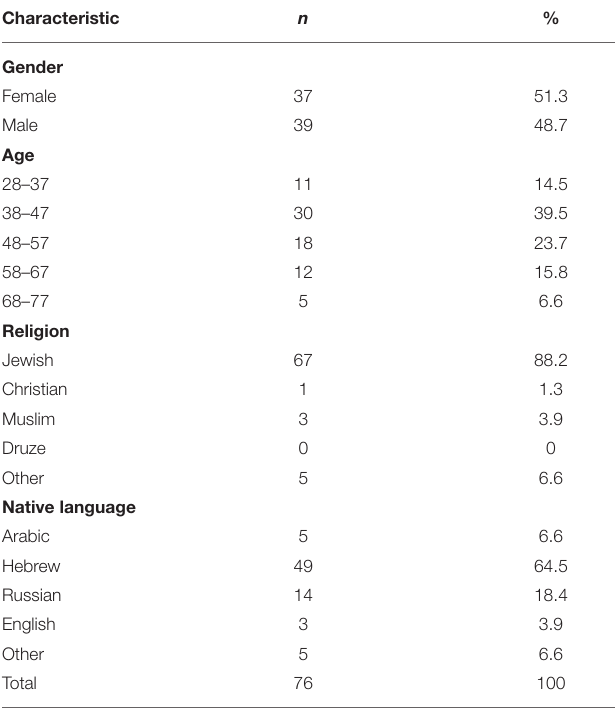
TABLE 1 | Demographic data of the survey